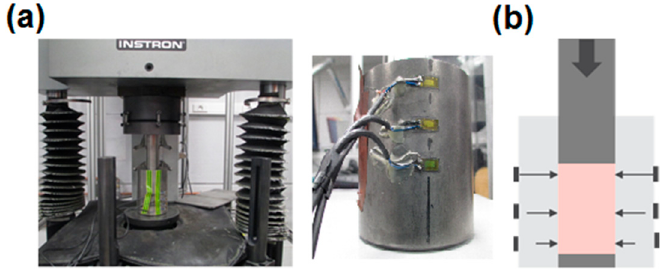
Figure 2. ( a ) Pressing machine used for formation of green bodies, location of radial stress meas- urements; ( b ) schematic representation of cylindrical greed body with pressure sensor locations.